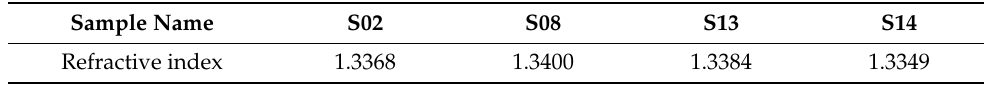
Table 5. Refractive index of the investigated samples.